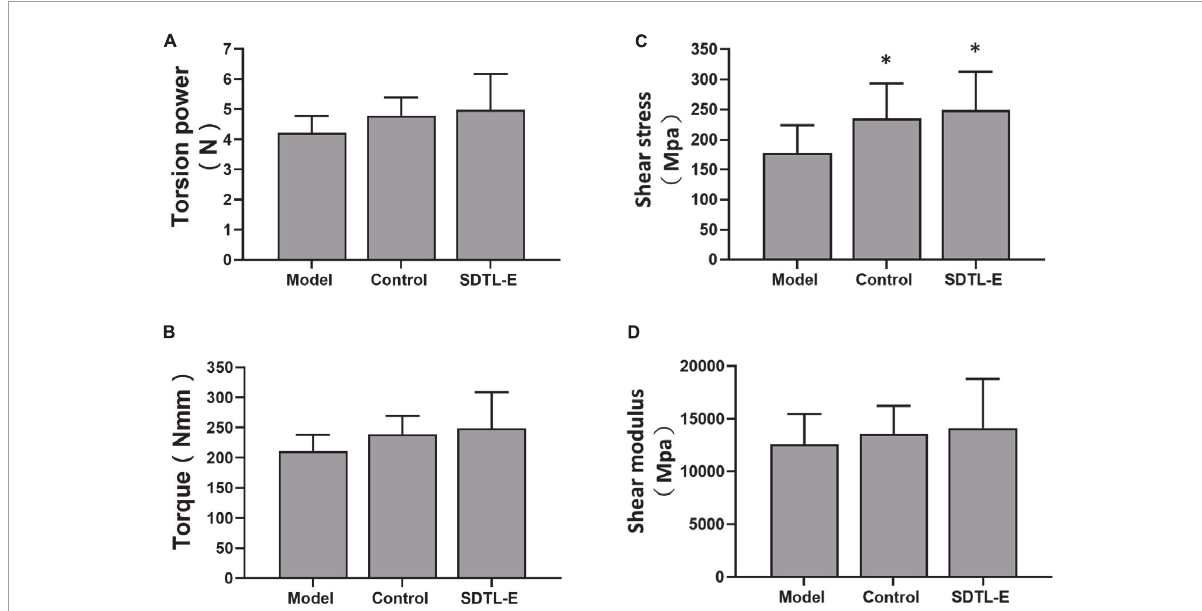
FIGURE7 SDTL-E treatment increased bone strength of OVX-induced osteoporosis rats. Model Group ( n = 9) and Control Group ( n = 11) rats were treated with vegetable oil. SDTL-E Group ( n = 9) rats were treated with SDTL-E. All treatments were topically applied twice daily for 20 days. Bone mechanics parameters, (A) torsion power (B) torque (C) shear stress and (D) shear modulus were determined by bone torsional testing. Values are mean ± SD . ∗ p < 0.05 vs. Model